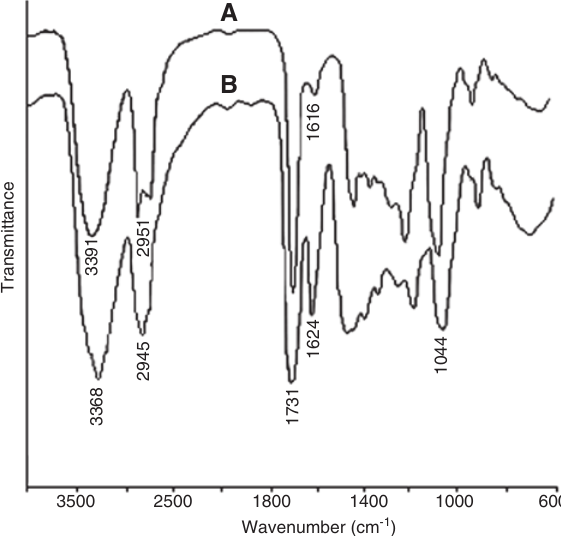
Figure 1 FT-IR spectra of (A) N,N-2-hydroxyethyl-3-amino methyl propionate monomer and (B) G2 HPAE.